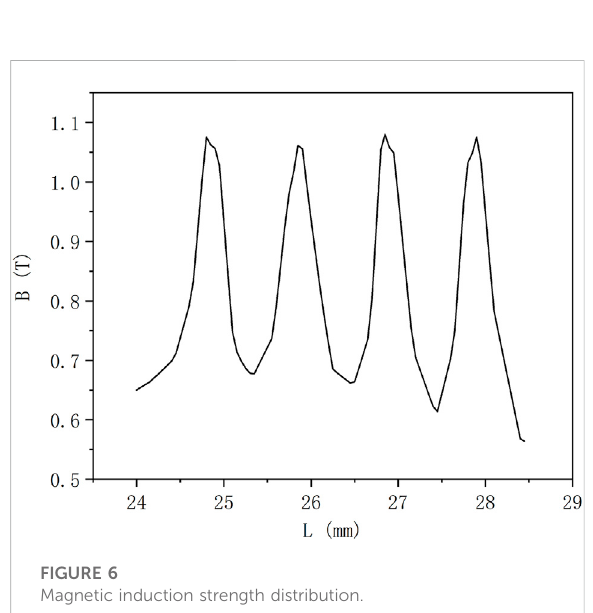
FIGURE 5 Path selection diagram.